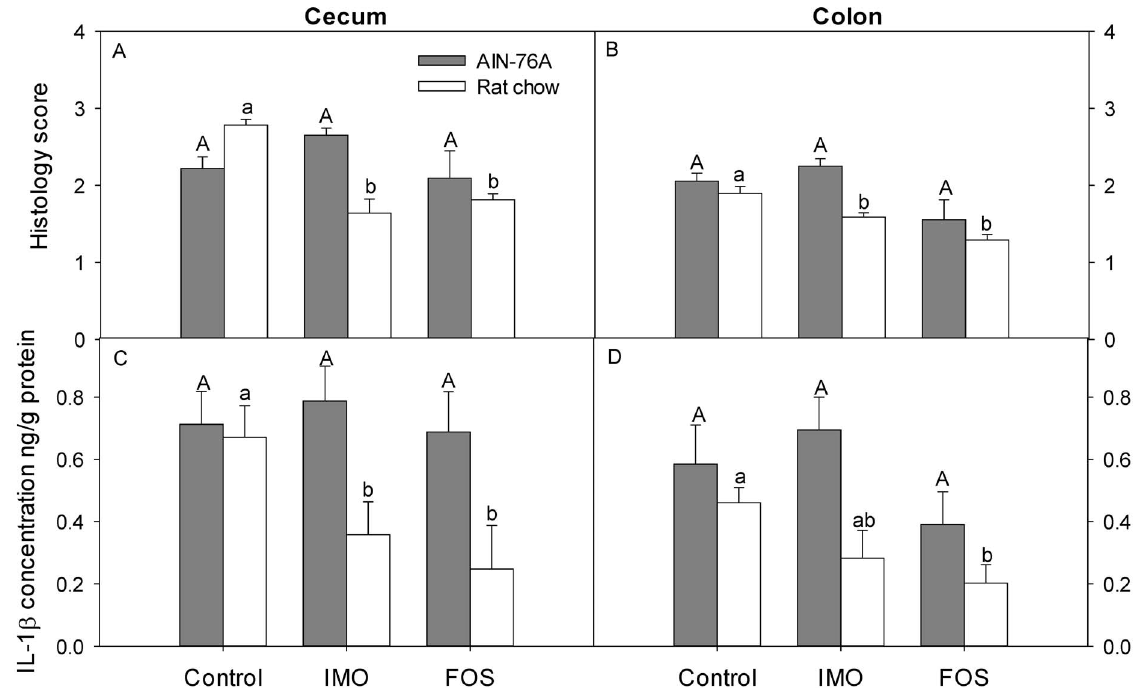
Figure 1. Effect of diet in intestinal inflammation. Inflammation was assessed by histological scoring of inflammation in cecum (panel A) and colon (panel B), and by quantification of the IL-1 b in cecal (panel C) and colonic (panel D) tissues collected from HLA-B27 transgenic rats fed AIN-76A or rat chow diet supplemented either with FOS or IMO, or not supplemented. Values are expressed as means 6 SEM, n=6 and n=8 for rat chow and AIN-76A diet, respectively. Values in the same panel that do not share a common superscript differ significantly ( P , 0.05, Bonferroni adjustment).